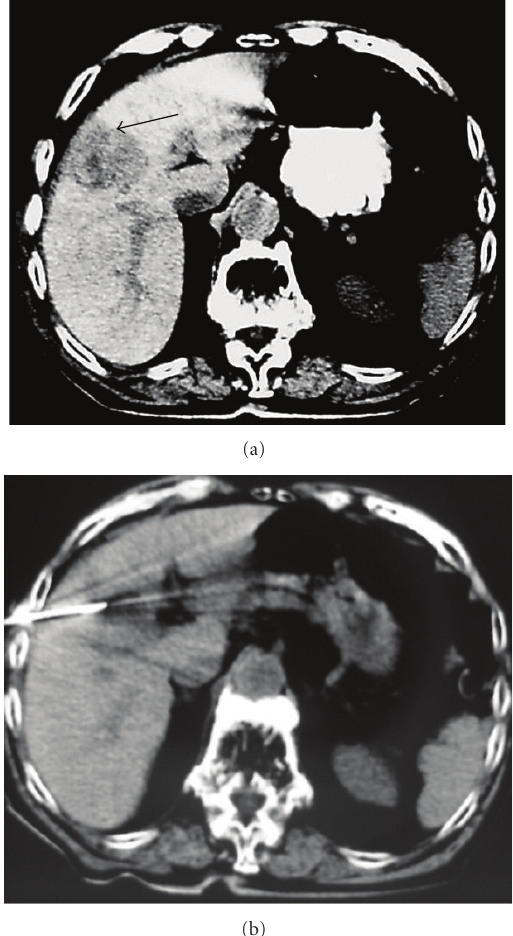
Figure 1: (a) A hypodense lesion with maximum diameter of 4.5cm located in the IVth segment of the liver (arrow), with signs of early arterial enhancement, consistent with HCC characteristics. (b) The tip of the electrode is seen inside the lesion during the first RFA session.